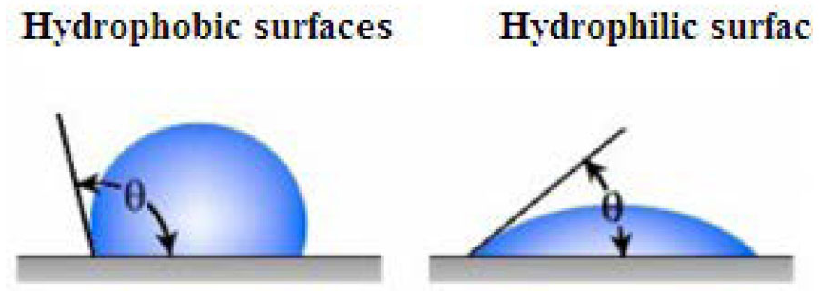
Figure 22. Contact angle for hydrophilic and hydrophobic planes. Source: IOP Conference Series: Materials Science and Engineering, Preliminary Tests for Ti-Mo-Zr-Ta Alloys as Potential Biomaterials, IPO, DOI: 10.1088/1757-899X/374/1/012023, IPO. License: CC BY 3.0 [89].